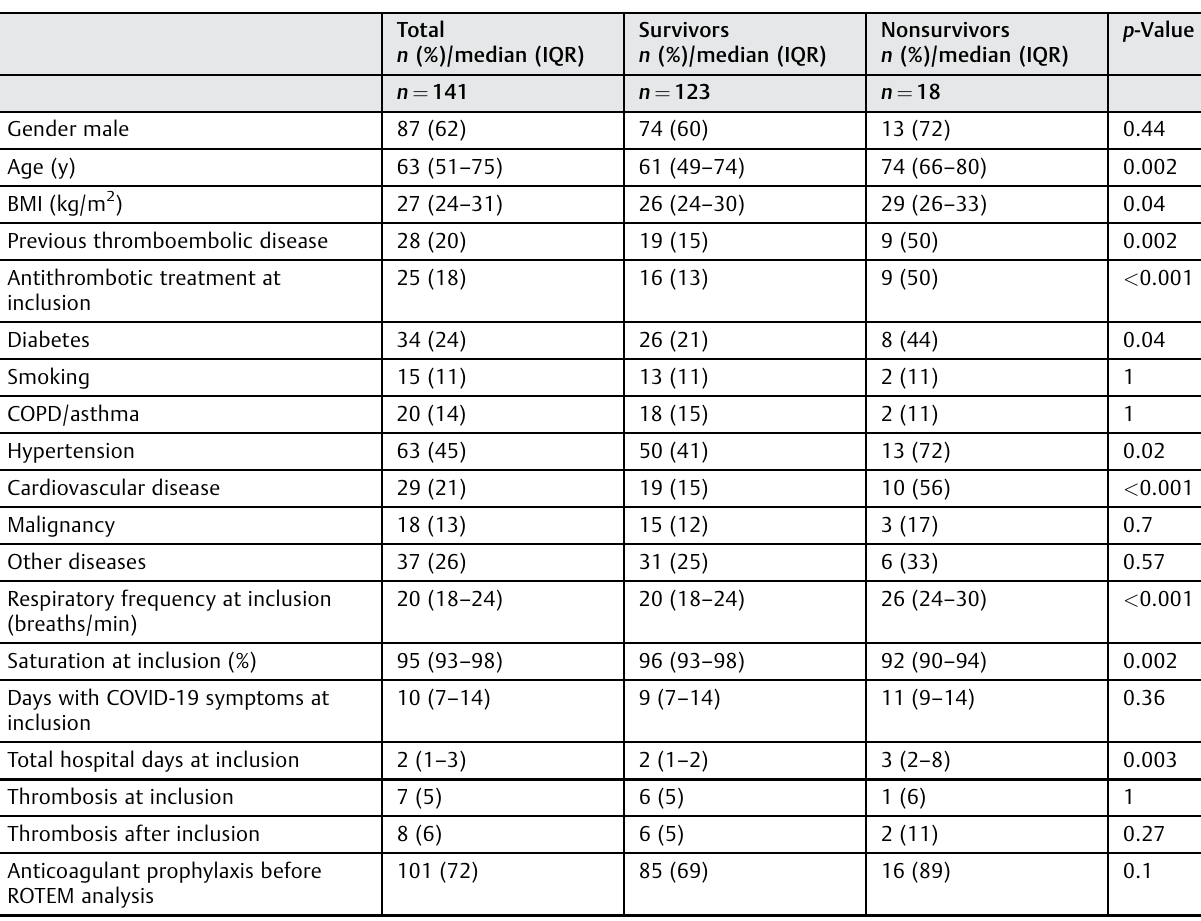
Table 1 Baseline characteristics: survivors and